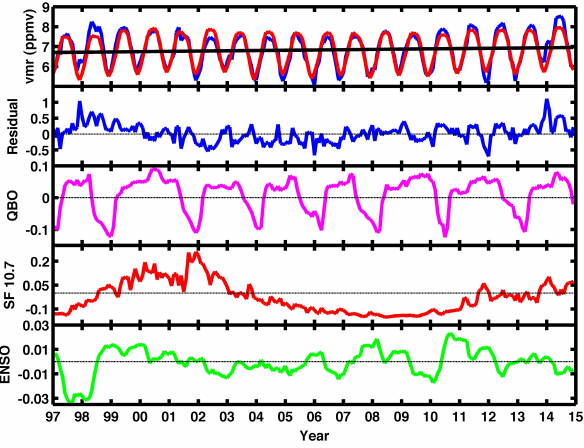
Figure 7. The first panel shows the trend fit at 10hPa, with the GROMOS monthly mean data (blue line), the calculated fit (red line) and the related trend (black line). The second panel shows the residual and in the following panels the fitted signals of the prox- ies QBO (magenta line), solar F10.7cm flux (red line) and ENSO (green line), at